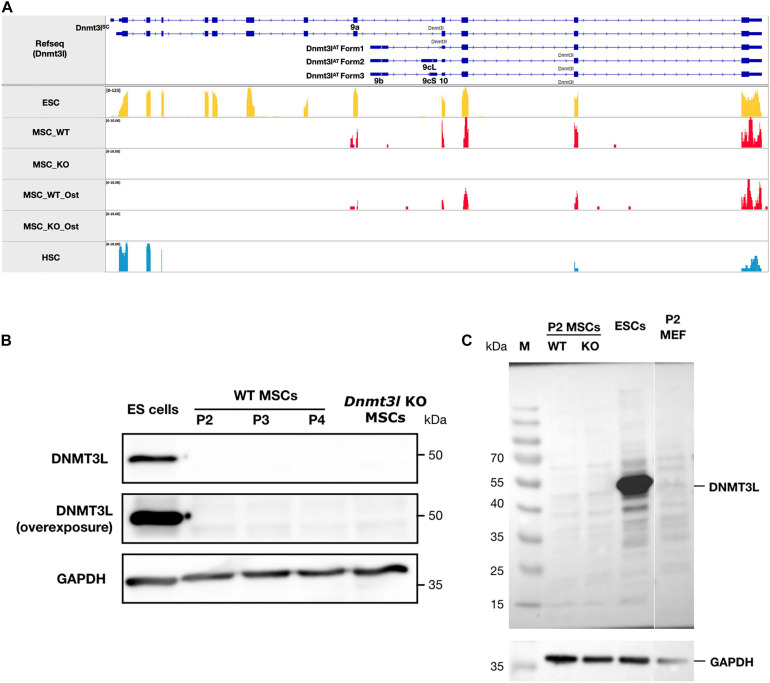
The ∼50 kDa canonical stem cell form of DNMT3L protein is not detectable in MSCs. (A) No sequencing reads were mapped to exons 1–8 of Dnmt3l suggesting no canonical ∼50 kDa DNMT3L expression in MSCs. However, a potential novel isoform of Dnmt3l transcript starting from exon 9a can be observed to be expressed in low level in wild type but not Dnmt3l KO mice derived BM-MSCs. In contrast, 3 Dnmt3l isoforms that were described in adult testes previously all starting from exon 9b. (B) The canonical stem cell form of ∼50 kDa DNMT3L expression is highly expressed in ES cells detected by Western blotting. However, even under overexposure, there were no detectable DNMT3L signals at early passage (P2, P3, and P4) of MSCs. (C) Possibility of small DNMT3L (estimated to be 126 AA of around 20 kDa) expression has not been excluded but no distinct bands may be observed from our Western analysis of the MSC samples.